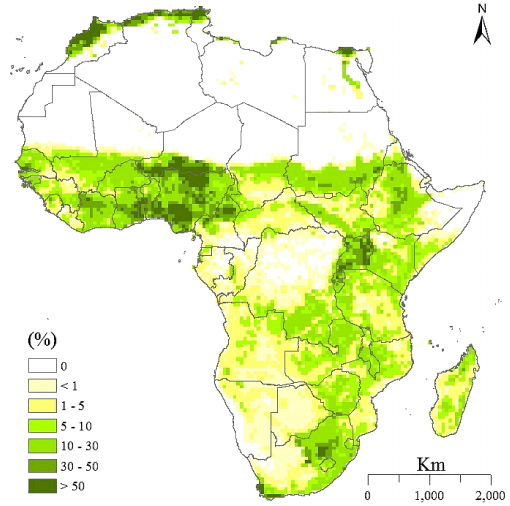
Figure 1. Proportion of cropland per cell (0.5 x 0.5 degree) in 2000 (Ramankutty et al., 2008).